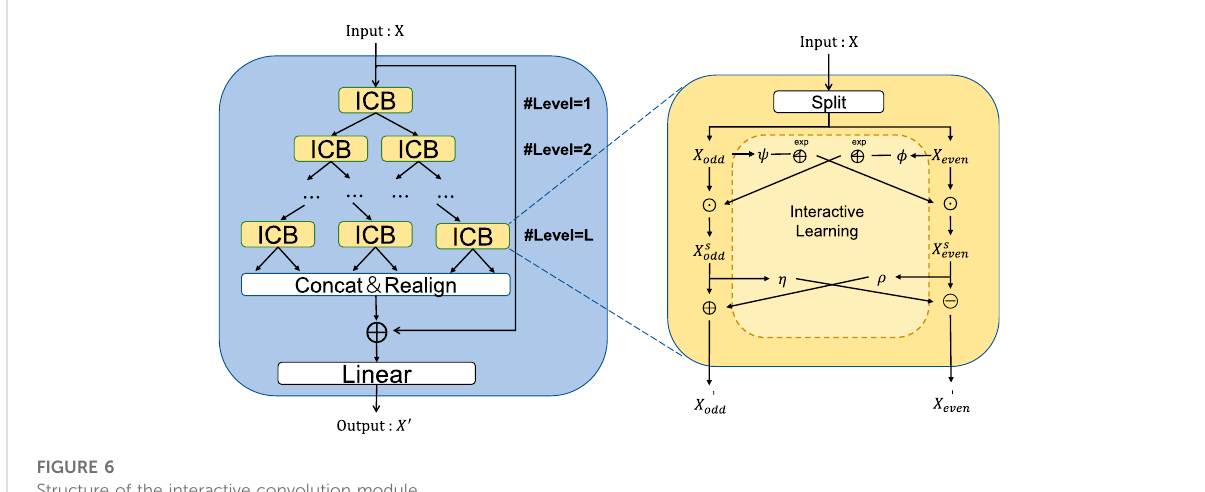
FIGURE 6 Structure of the interactive convolution module.